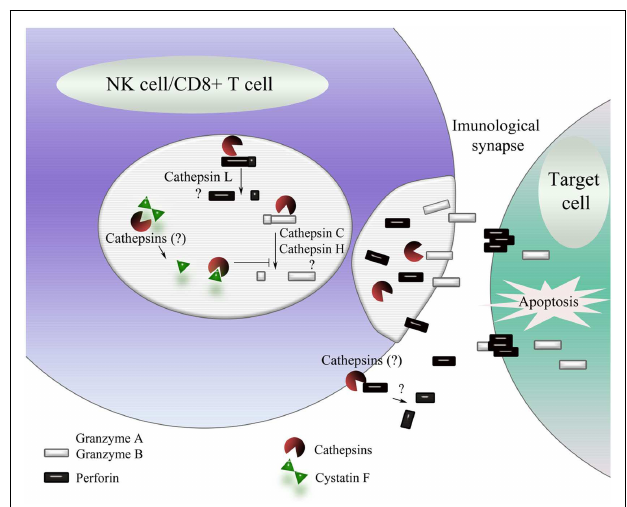
FIGURE 2 | Schematic representation of the regulation of NK cell/CD8 + T cell cytotoxicity by cathepsins . On target cell recognition, cytotoxic cells secrete the content of their cytotoxic granules into the immunological synapse, leading to the caspase-dependent or independent cell death of target cells.The major cytotoxic mediators are activated by limited proteolysis by cathepsins C and H (granzyme A and B) and, possibly, cathepsin L (perforin). N-terminally processed cystatin F is a potent inhibitor of cathepsins C, H, and L and thus a potential regulator of NK cell/CD8 + T cell cytotoxicity. Exocytosed cysteine cathepsins may also be involved in inhibition of perforin, contributing to self-protection of cytotoxic cells from the contents of their cytotoxic